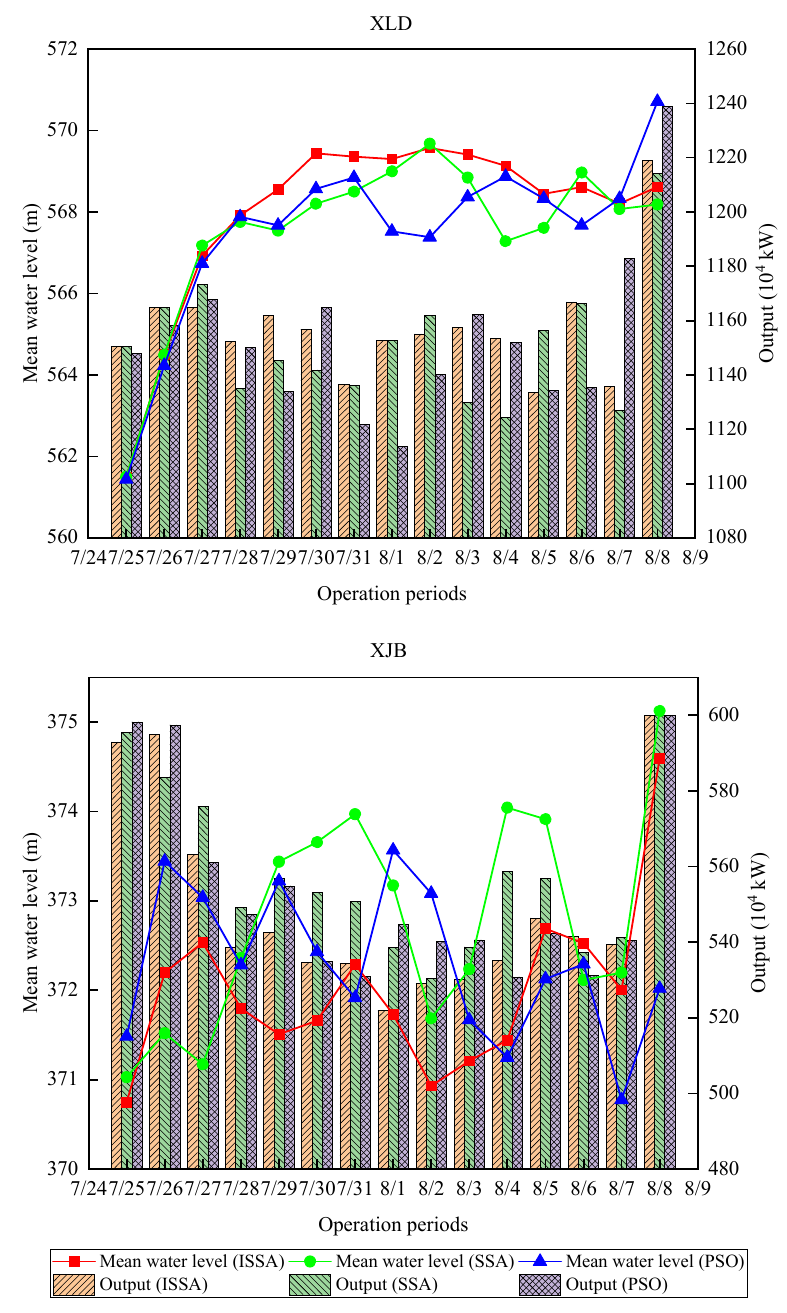
Figure 13. Mean water level and output processes of XLD and XJB. Table 7. Storage volume of XLD and XJB cascade reservoirs.